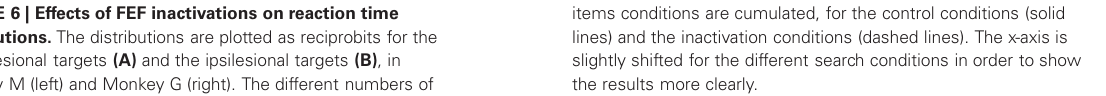
items conditions are cumulated, for the control conditions (solid lines) and the inactivation conditions (dashed lines). The x-axis is slightly shifted for the different search conditions in order to show the results more